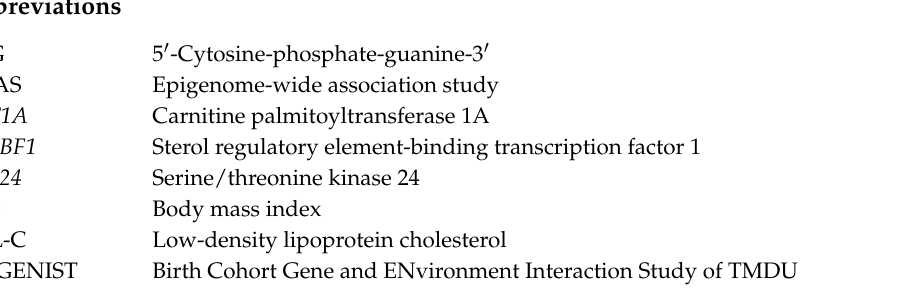
information; Table S3: Methylation correlation matrix; Figure S1: Pre-pregnancy BMI and gestational BMI at T1 and T2; Figure S2: Association of LDL-C and methylation levels at mid- and late gestation; Figure S3: Construction of a reference curve for the relationship between observed neutrophil proportion (%) and methylation levels at STK24 _CpG2 (cg23954655); Figure S4: Correlation between estimations of neutrophil proportion change derived from two different neutrophil markers; Figure S5: The relationship between observed lymphocyte proportion (%) and methylation levels of CPT1A intron